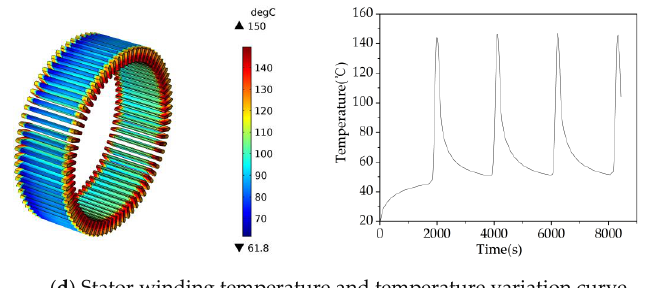
Figure 17. Temperature of each component of IWM.